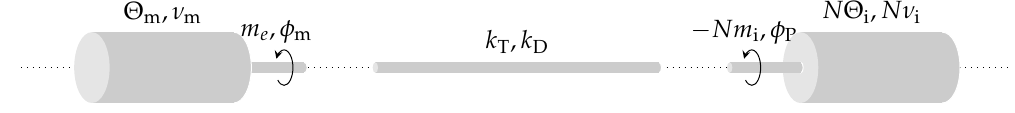
Figure 11. Free body diagram of a rotational two mass